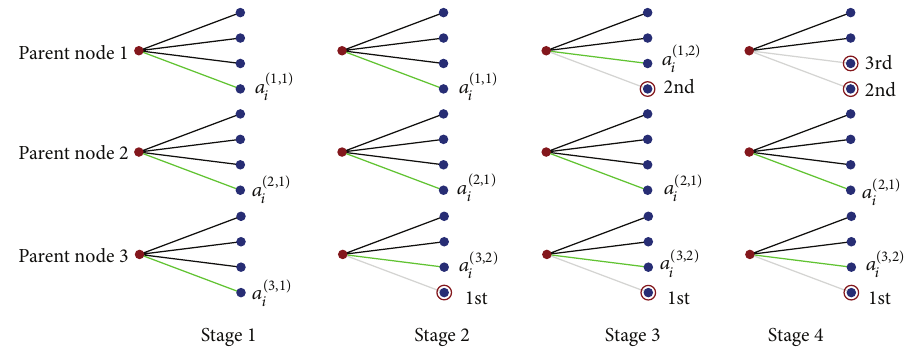
Figure 3: Illustrative example of the WPE distributed sorting algorithm for a system with 𝐾 = 3 and 𝐵 = 4 .